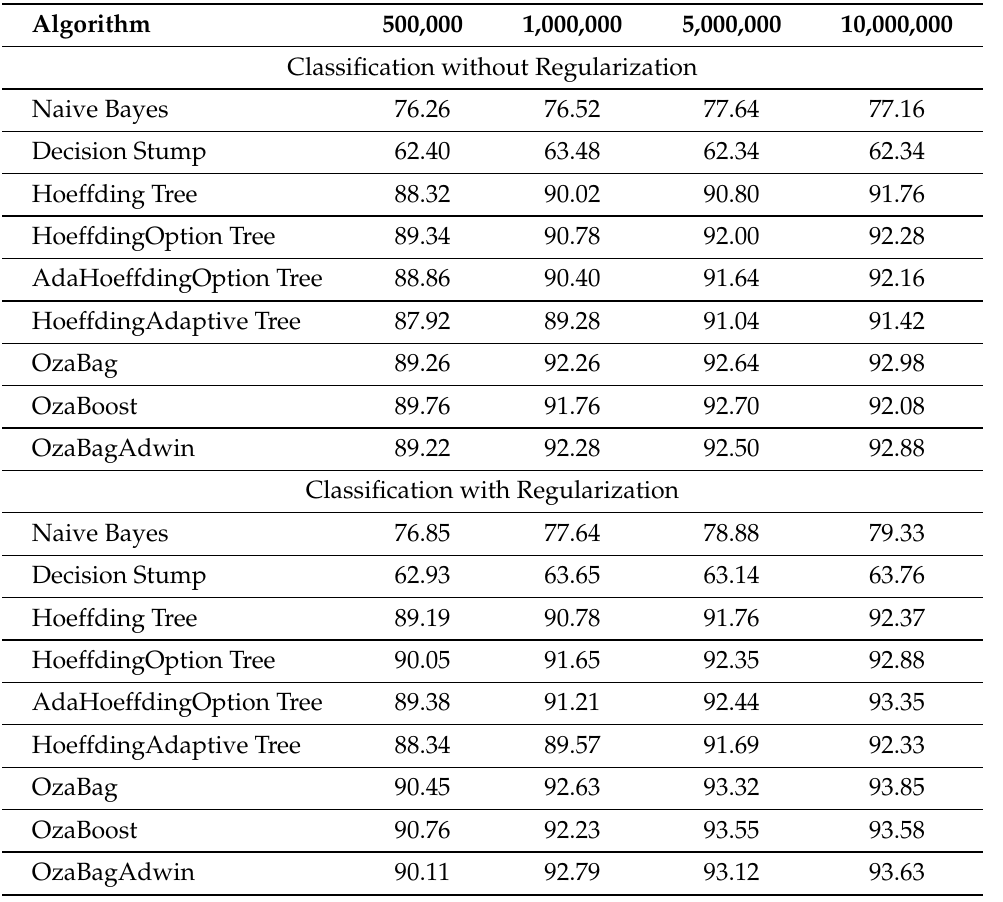
Table 8. Accuracy percentages of weather classification for different dataset sizes for training set =